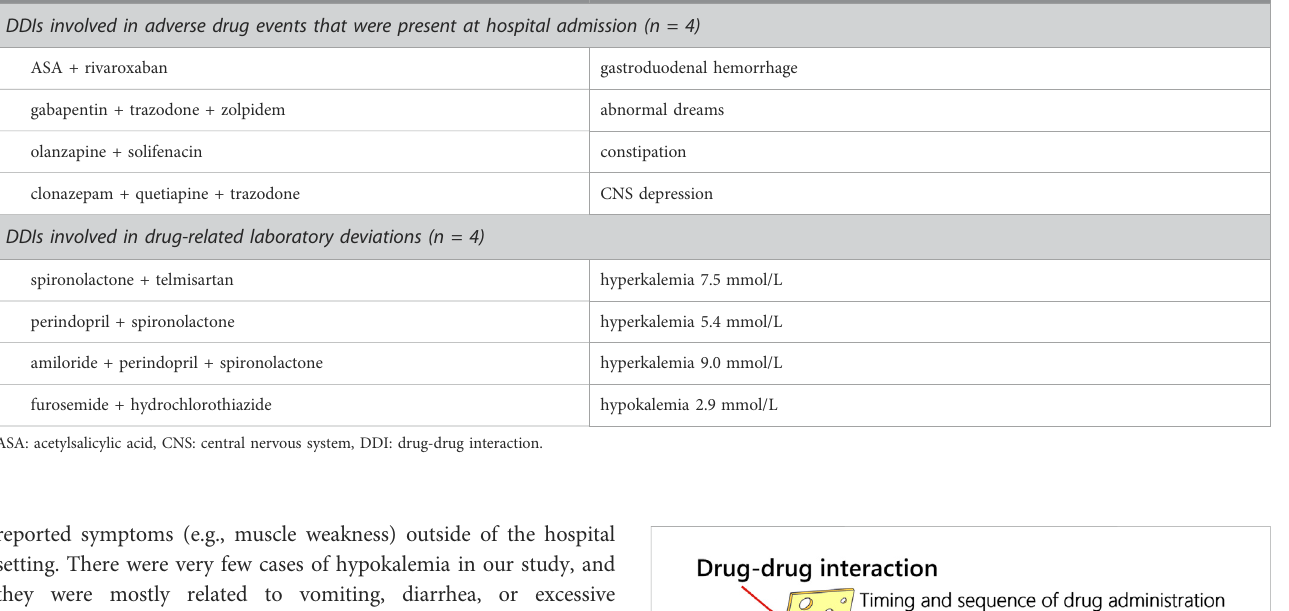
TABLE 4 List of other manifest DDIs ( n = 8). Manifest drug-drug interaction Adverse drug event or laboratory deviation